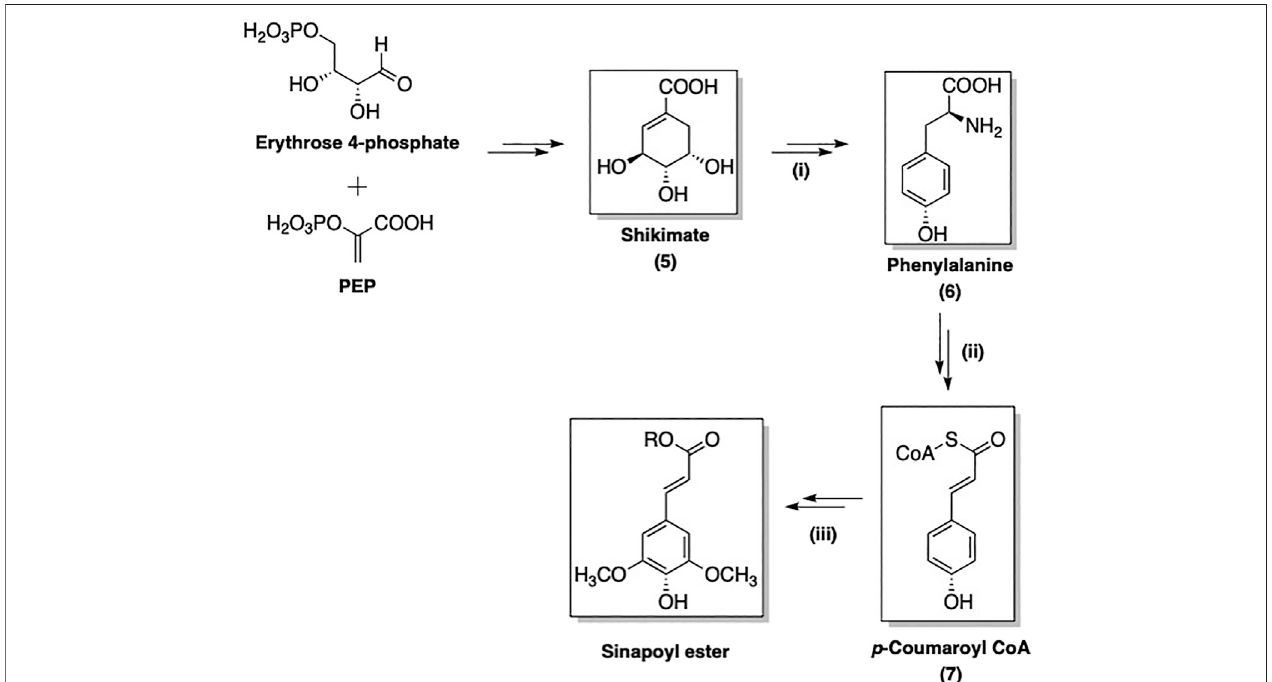
FIGURE 2 | Three main stages of SinE biosynthesis: (i): Formation of Phe; (ii): Formation 4-coumaroyl CoA intermediate; (iii) Formation of sinapoyl esters.